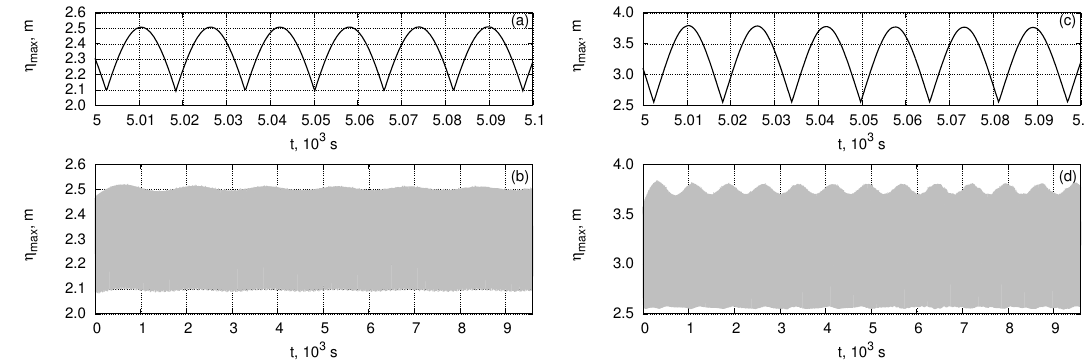
Figure 4. Behaviour of the maximum value of the surface elevation η max , when single breathers with the wave steepnesses µ ≈ 0.15 ( a , b ) and µ ≈ 0.25 ( c , d ) propagate in the fully nonlinear model. The upper row pictures are 100 x zoom of the lower row pictures. The fast oscillations of the function η max ( t ) caused by evolution of the breather phase can be seen in the upper row pictures, which have small time scale. In the large time scale lower row pictures, these oscillations cannot be distinguished, but instead of that, one can see the effect of oscillations of maximum value of the surface elevation